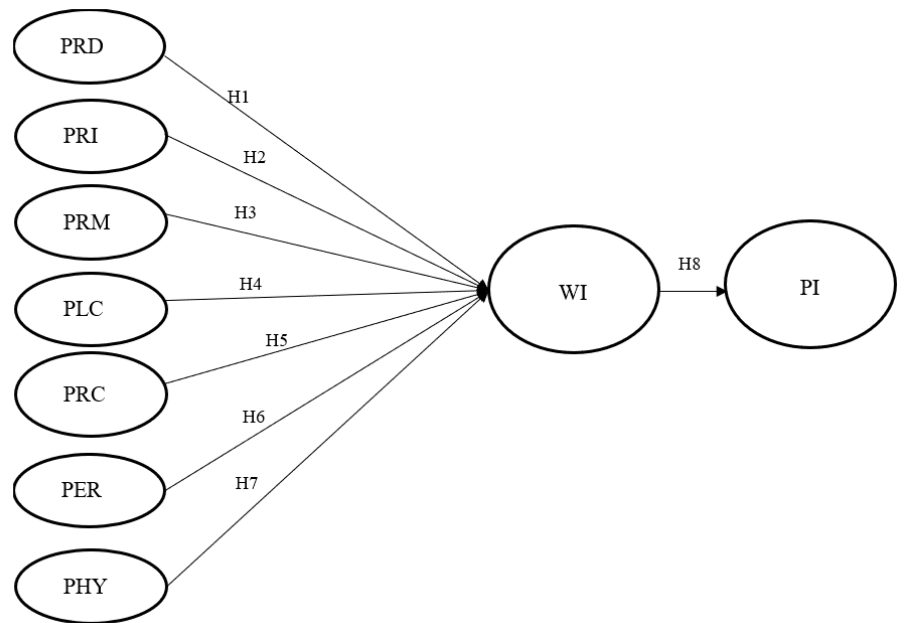
Figure 2. Research framework for testing customers’ watching intention as the mediator variable (Model 2). Note: Please refer to Appendix A Table A1 for the abbreviations of the constructs.